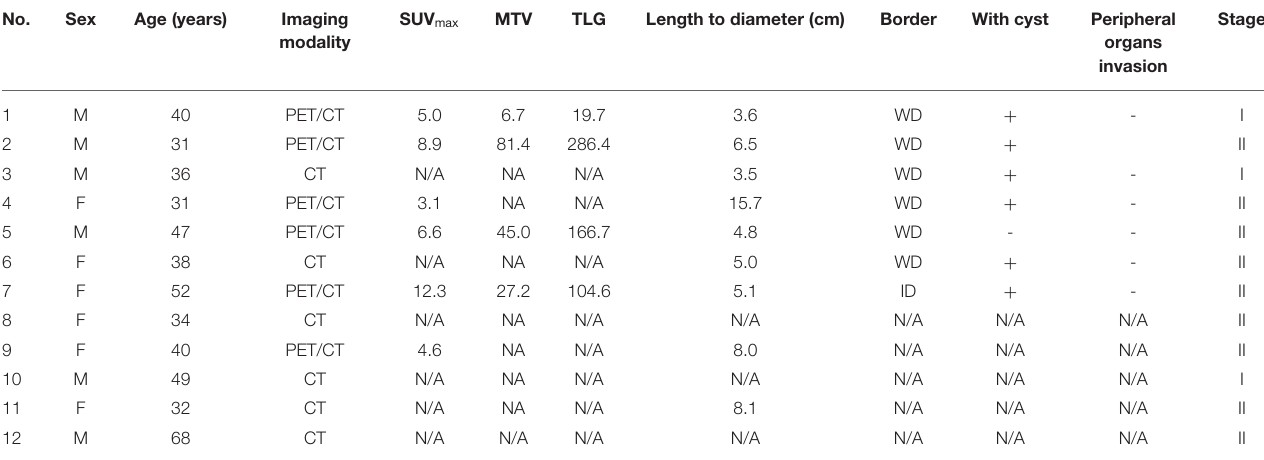
TABLE 3 | CT or PET/CT features and staging in patients with thymic MALT lymphoma. No. Sex Imaging SUV max Length to diameter (cm) Border With cyst Peripheral modality